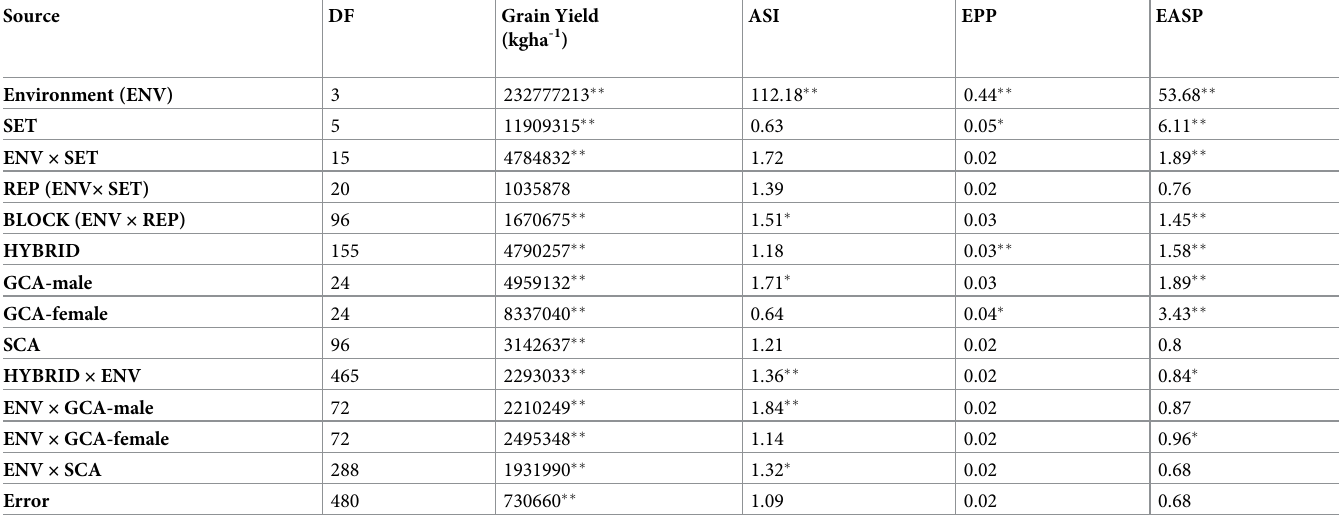
Table 5. Mean squares of grain yield and other agronomic traits of extra-early maturing pro-vitamin A maize hybrids evaluated under optimal environments at Mokwa (2018 and 2019), Ile-Ife and Abuja (2018). Source DF Grain Yield (kgha -1 ) Environment